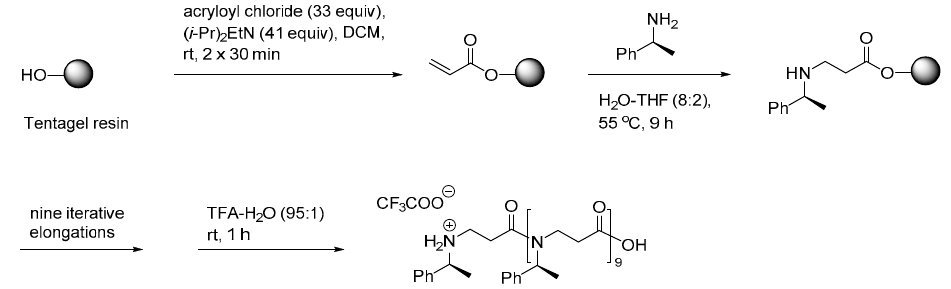
22 of 59 Figure 9. Structure of commonly used β -peptoid building blocks. β N Phe: N -(1-phenylethyl)- β - alanine; β N spe: N -( S )-(1-phenylethyl)- β -alanine; β N sce: N -( S )-(1-cyclohexylethyl)- β -alanine; β N Lys: N -(4-aminobutyl)- β -alanine; β N hArg: N -(3-guanidinobutyl)- β -alanine. 2.3.1. Synthesis of β -Peptoid Oligomers The first report on solid-phase synthesis (SPS) of β -peptoid oligomers concerned assembly of a combinatorial library of trimers starting from an acryloylated Wang resin. Elongation was performed via a submonomer approach involving successive aza-Michael addition of an appropriate primary amine in DMSO (which proved superior to DMF, NMP or DCE) and acylation with acryloyl chloride in the presence of triethylamine (Scheme 2). Typically, each elongation cycle reached 2.5 day even for unhindered amines [208]. Scheme 2. SPS of achiral β -peptoids via the submonomer aza-Michael method